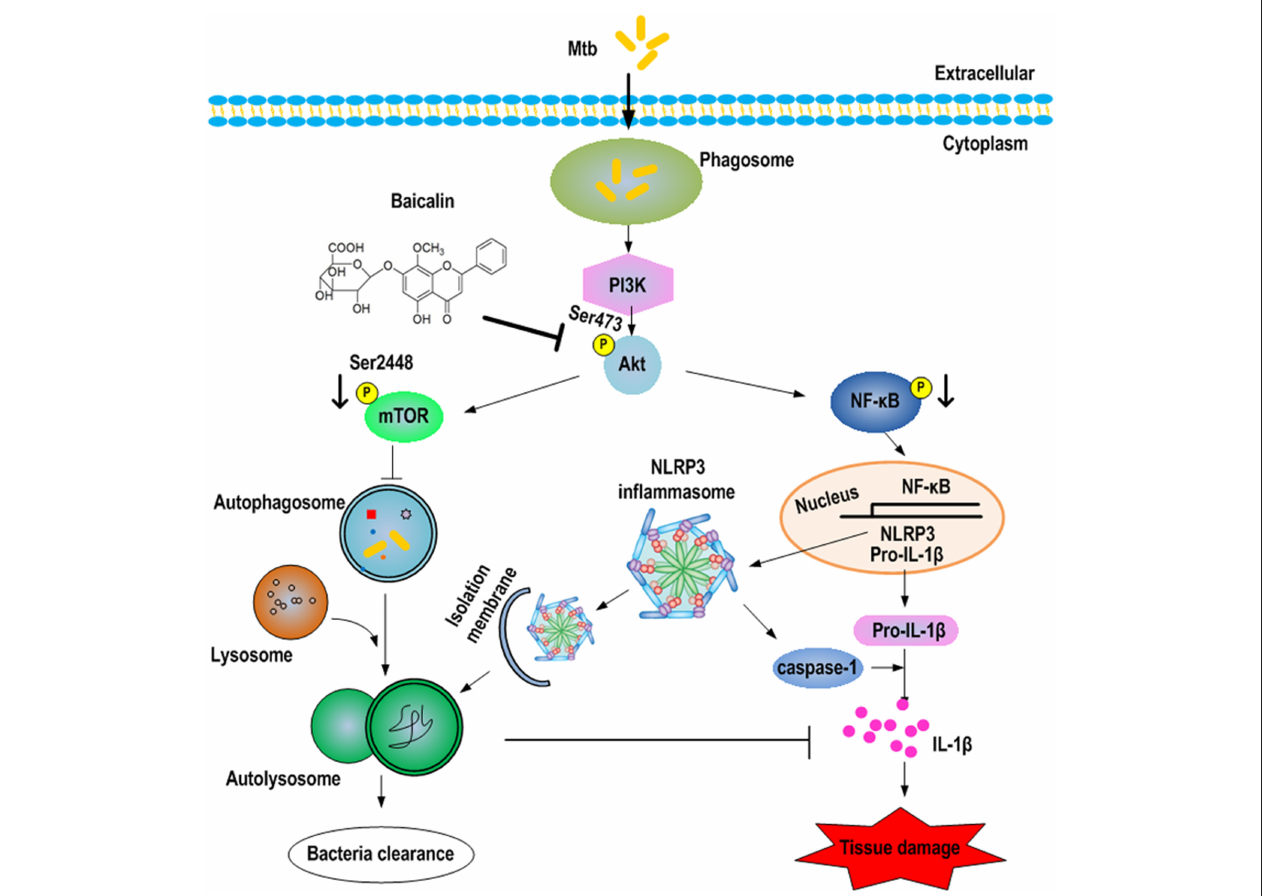
FIGURE 12 | Schematic summary of baicalin-driven regulation of autophagy and inflammation during Mtb infection. Baicalin inhibits the phosphorylation of Akt, thus inducing the activation of autophagy through PI3K/Akt/mTOR signaling pathways leading to bactericidal and inflammasome-inhibitory effect. Furthermore, baicalin inhibits the PI3K/Akt/NF- κ B pathway contributing to the inhibitory effect on NLRP3 inflammasome